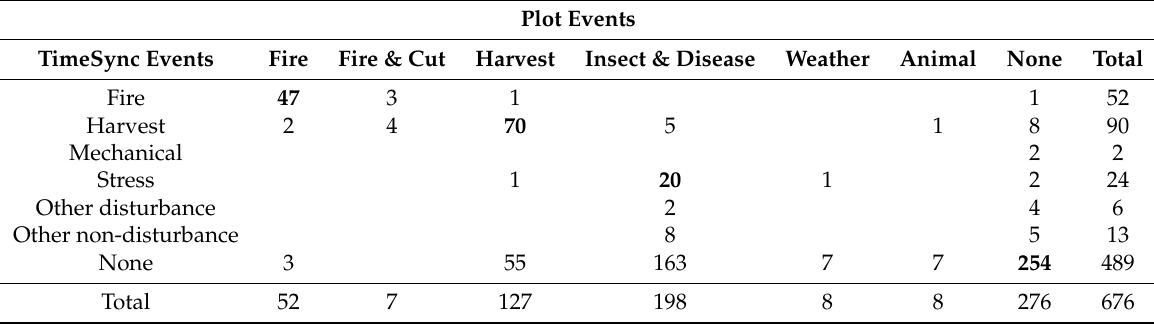
Table 2. Matrix of plot-based and TimeSync-based classifications of disturbance. Values are numbers of plots, values in bold are matches in disturbance types.